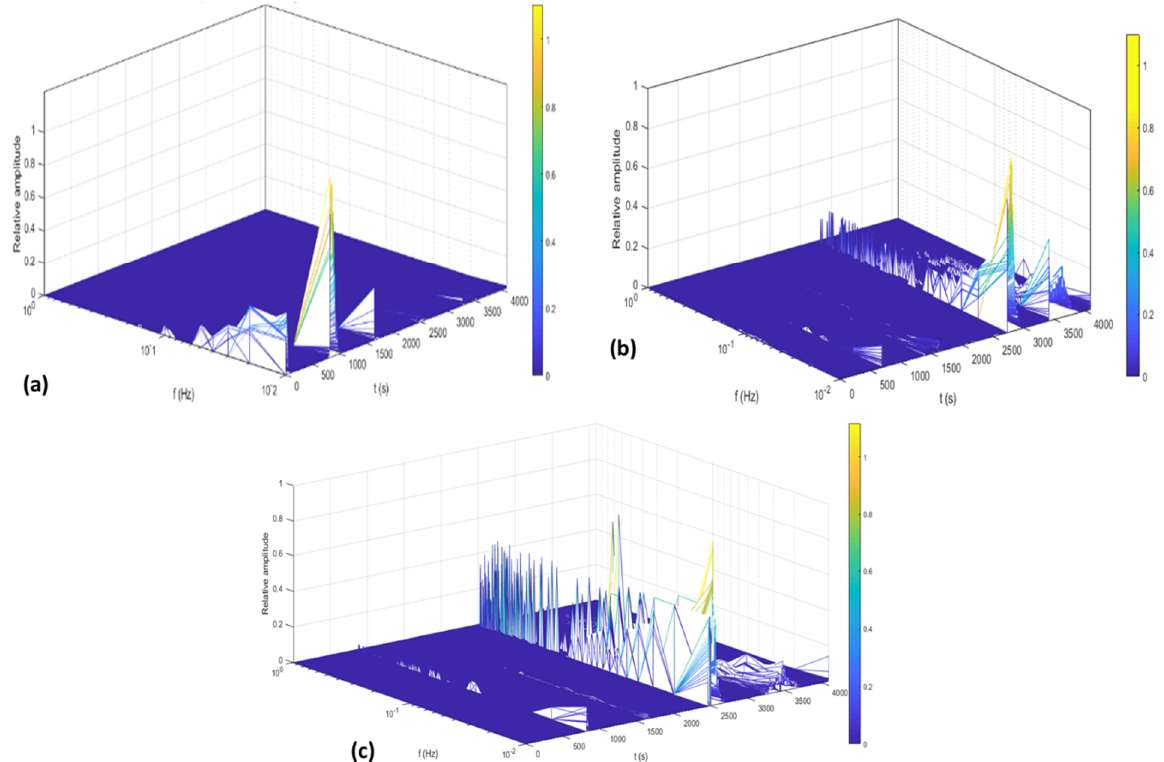
Figure 6. The Hilbert spectra of Ti alloys for ECN data in 3.5 wt. % NaCl solution. ( a ) Ti CP2 ( b ) Ti-6Al-2Sn-4Zr-2Mo ( c ) Ti-6Al-4V.